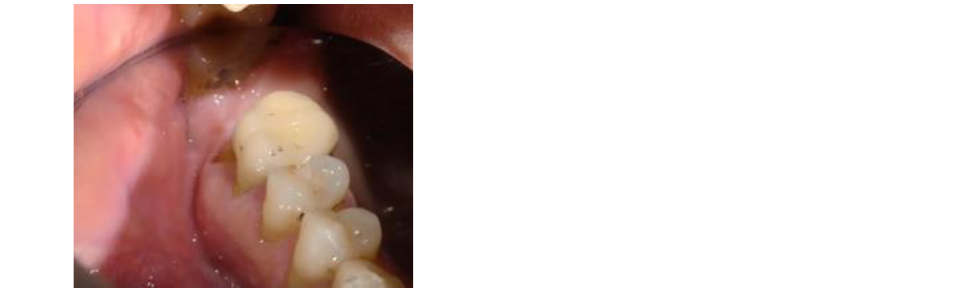
Figure 2. Detail of the design of the vestibular flap.